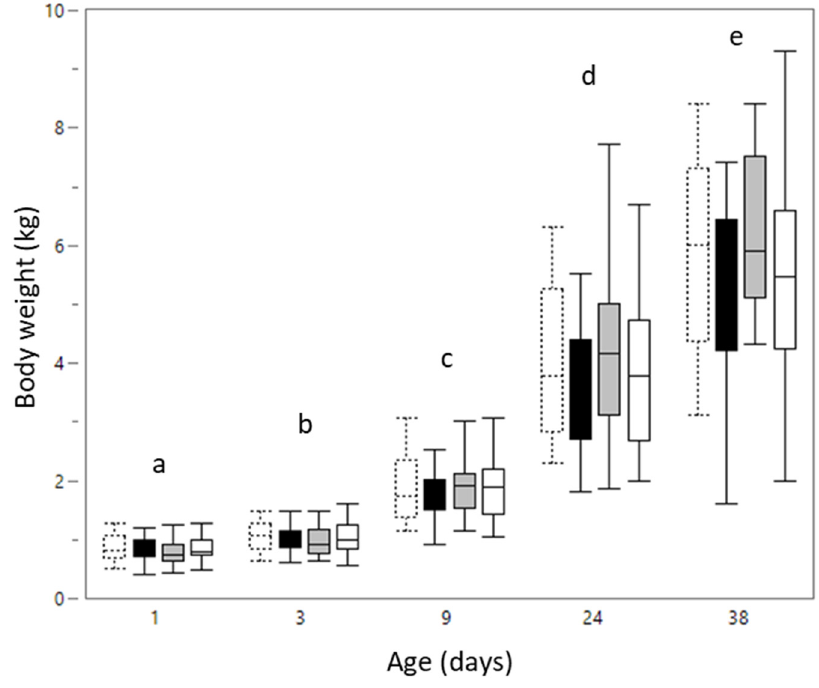
Figure 1. Boxplot of body weight from low birth weight piglets that were drenched with milk replacer (dashed box: d1 n = 38, d3 n = 30, d9 n = 25, d24 n = 22, d38 n = 21), bovine colostrum (black box: d1 n = 38, d3 n = 28, d9 n = 22, d24 n = 19, d38 n = 18), short-chain fructo-oligosaccharides (grey box: d1 n = 39, d3 n = 23, d9 n = 15, d24 n = 14, d38 n = 21 n = 11) or quercetin (white box: d1 n = 36, d3 n = 26, d9 n = 21, d24 n = 19, d38 n = 18) once a day from day 1 until day 7. Body weight is day 38 ( n = 68). Significant age differences (linear mixed models, Tukey post-hoc analysis, p ≤ 0.05) are indicated by a different letter